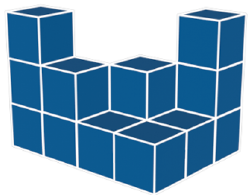
Figure 4. Conventions for partitions and reverse plane